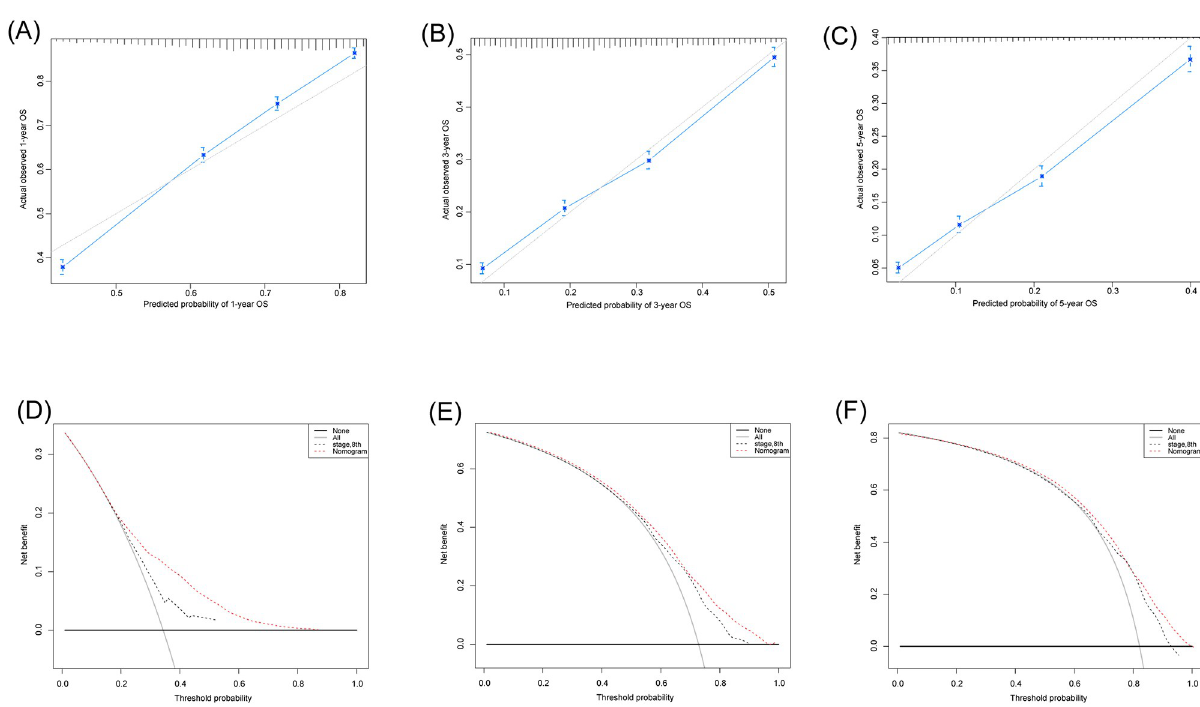
Fig 2. Calibration curves of the nomogram for predicting the 1- (A), 3- (B), and 5- (C) year OS rates of patients with PC. Decision curve analysis of the AICC 8th TNM stage, and nomogram for the 1- (D), 3- (E), and 5- (F) year OS rates of patients with PC. The black line represents the AICC 8th TNM stage, the red line represents the nomogram. OS: Overall survival; PC: Pancreatic cancer.